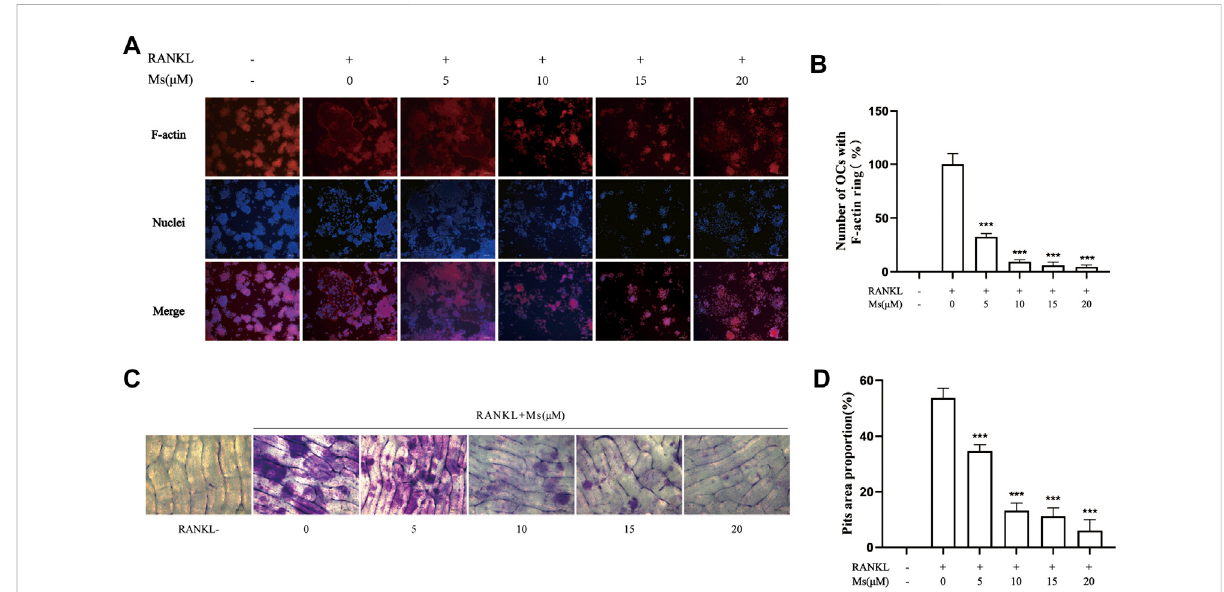
MsinhibitsformationoftheF-actinringandosteoclastresorptivefunctioninducedbyRANKL invitro .RAW264.7macrophageswereculturedin 24-well plates with or without Ms (5, 10, 15 and 20 μ M) in the presence of 50 ng/ml RANKL for 5 days. (A) Representative images of F-actin rings; F-actin: red, nuclei: blue, original magni fi cation ×200 (Scale bar = 200 μ m) (B) Quantitative analyses of osteoclast numbers with intact F-actin ring. RAW264.7 macrophages were cultured on a bone slice in 96-well plates with or without Ms (5, 10, 15 and 20 μ M) in the presence of 50 ng/ml RANKL for 7 days. (C) Resorption pits of osteoclasts were captured by a light microscope. Original magni fi cation ×200 (Scale bar = 200 μ m) (D) The resorbed areas were calculated using Image (J) . The results represent the mean ± SD of three independent samples. * p < 0.05, ** p < 0.01, *** p < 0.001 vs. Control (RANKL+, Ms-).